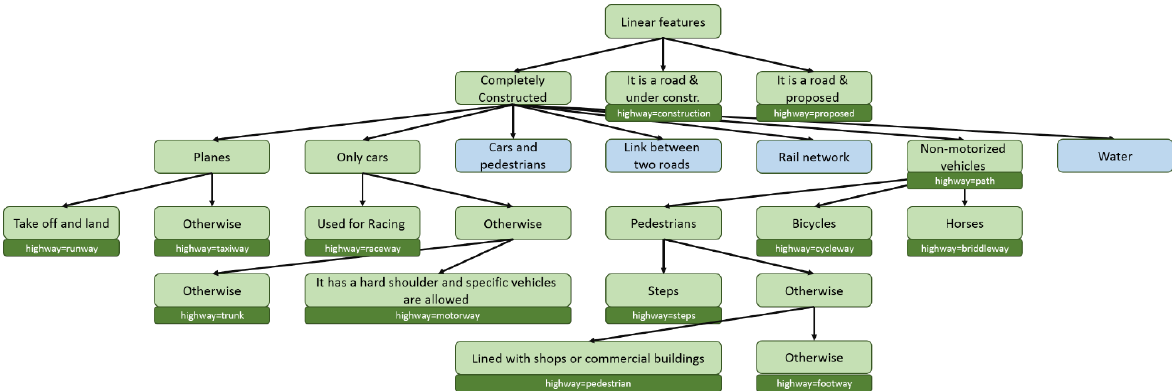
Figure 1. The resultant hierarchy to tag OpenStreetMap features.